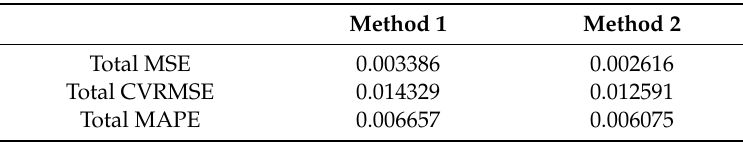
Table 7. Evaluation metrics of predict model for COP